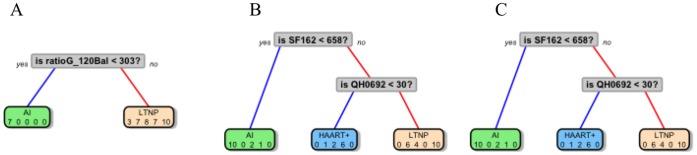
A pruned version of the optimal trees.